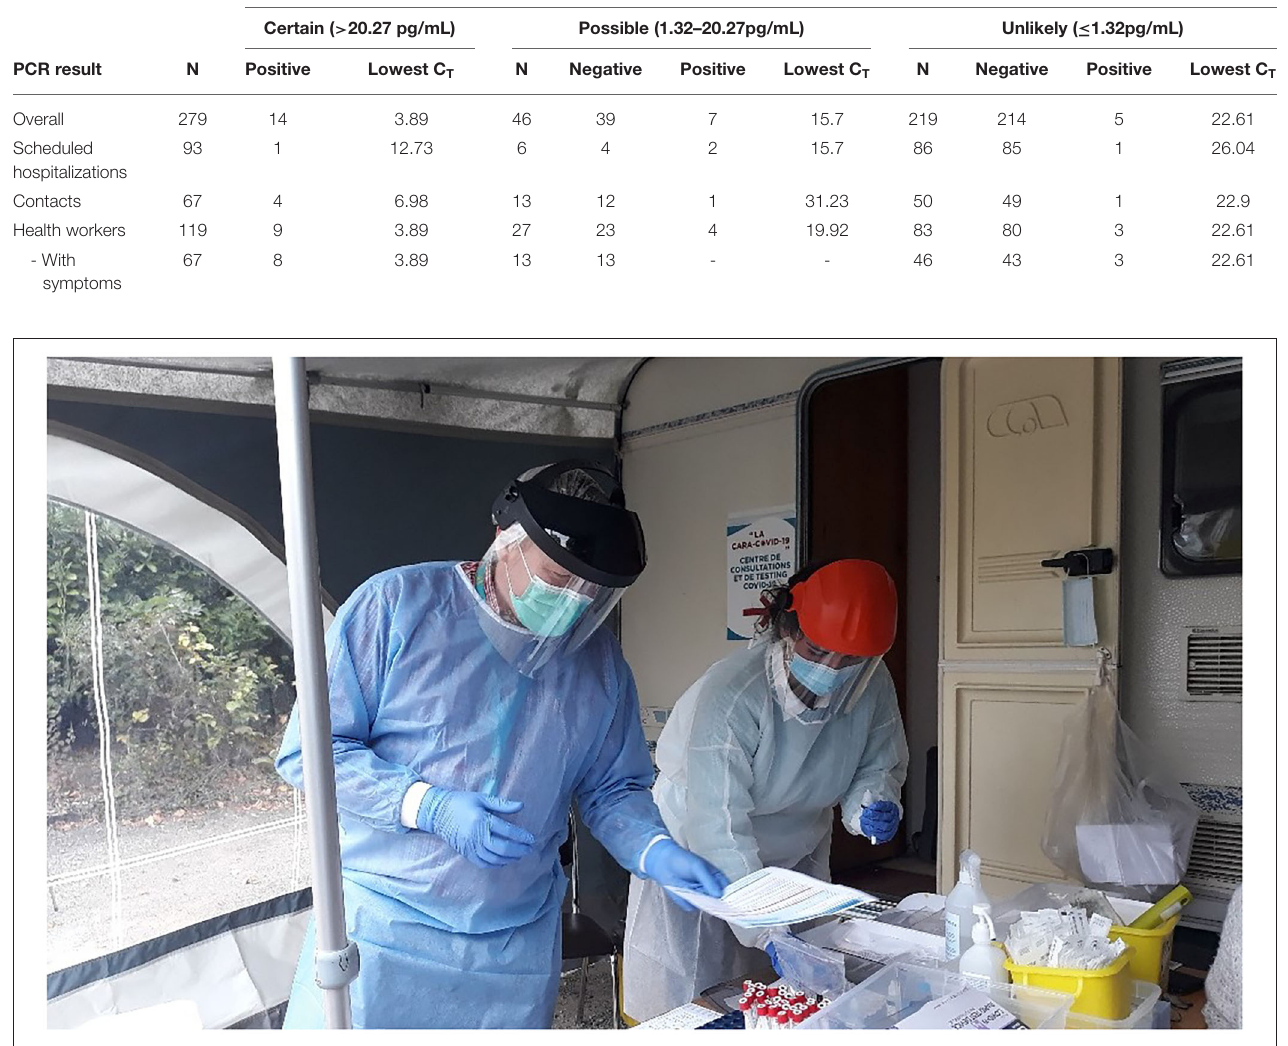
TABLE 4 | Analytical performances of the Lumipulse ® G SARS-CoV-2 Ag on target populations in the detection of SARS-CoV-2 using a categorization of the risk system. Lumipulse ® automated antigen